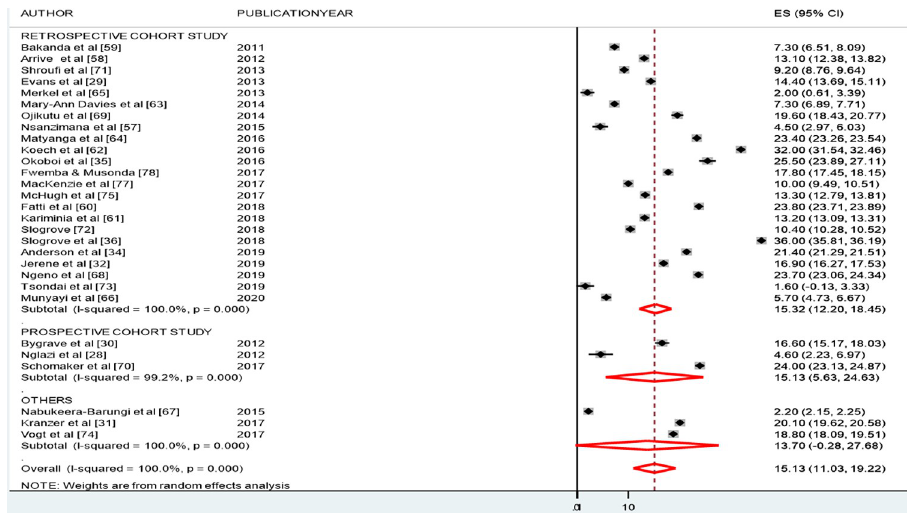
Fig 5. Subgroup analyses by study design on loss to follow-up among adolescents living with HIV and on ART follow-up in SSA.